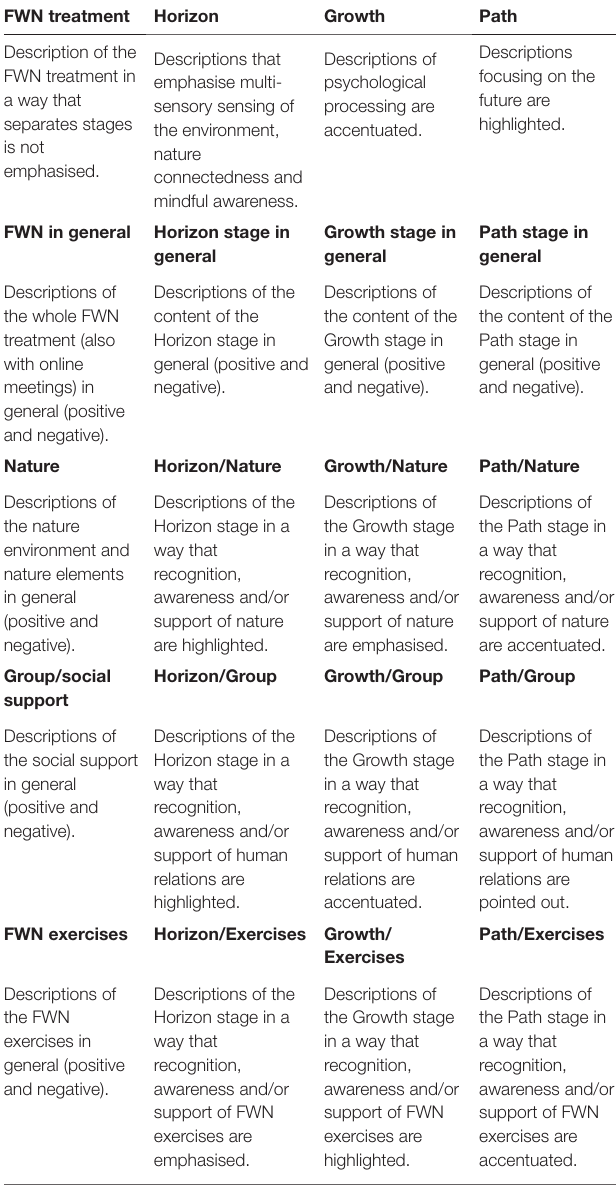
TABLE 2 | Flow with nature model (a categorisation